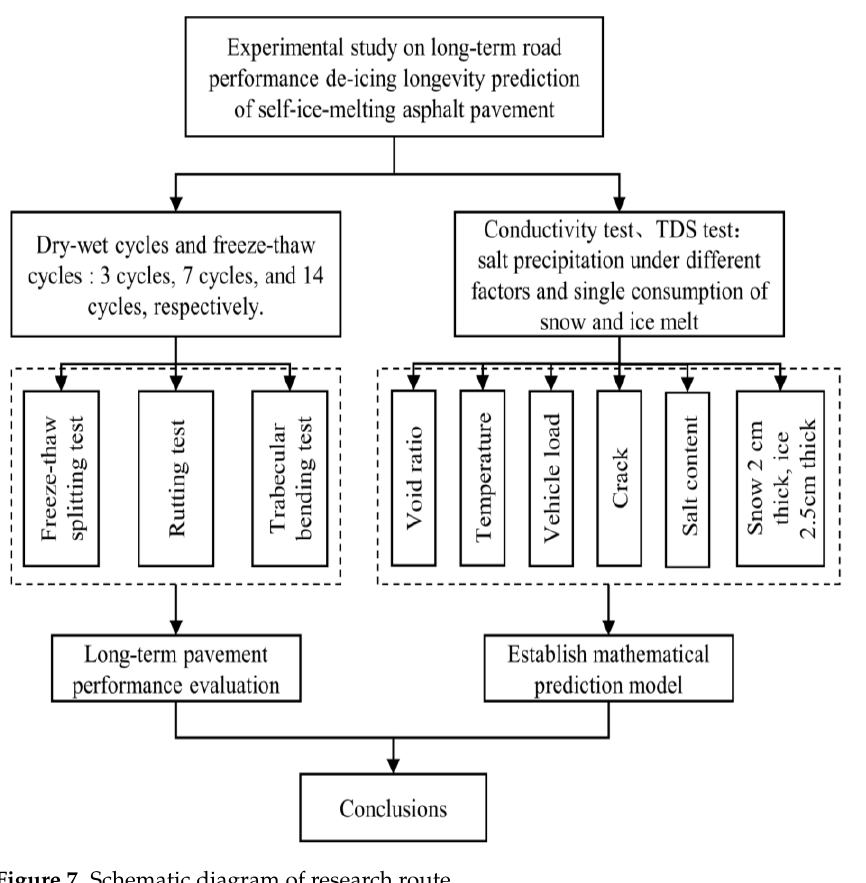
Figure 7. Schematic diagram of research route .